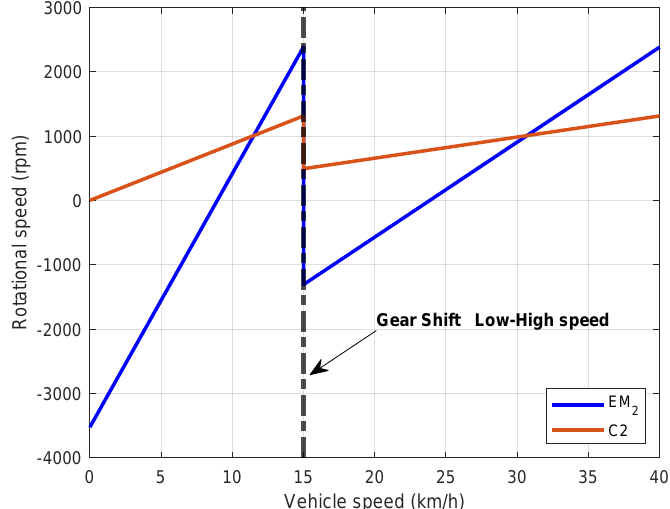
Figure 6. Kinematic relations between vehicle speed and EM 2 angular speed at fixed ICE rotational speed of 2350